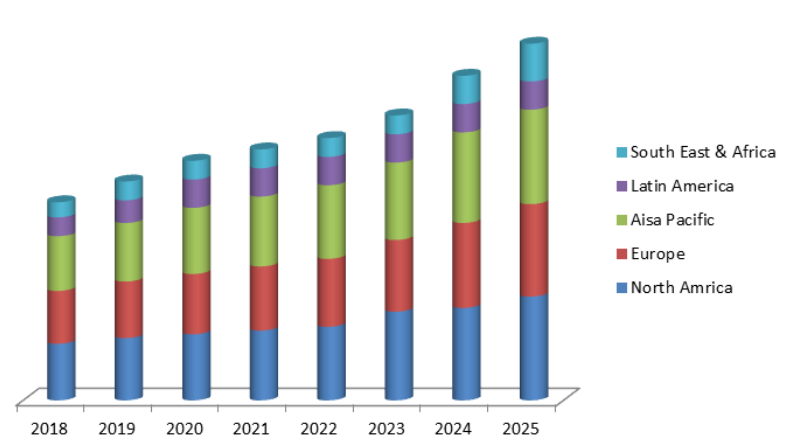
Figure 4. Geographic market distribution of smart bins with apparent growth around the